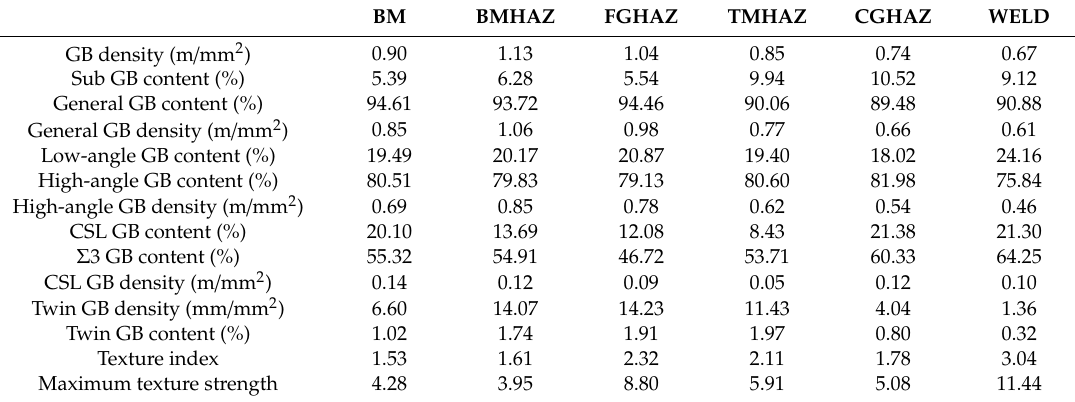
Figure 8. Histogram of coincident site lattice (CSL) distribution in each zone of the X100 laser-welded joint from the BM to the WELD. Table 3. The results of grain boundary (GB) of X100 laser welded joints by using electron backscattered di ff raction